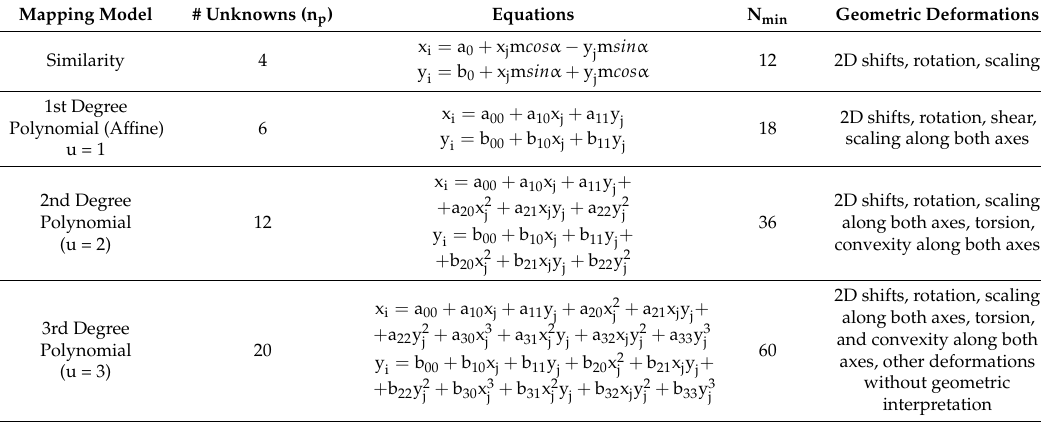
Table 1. Geometric registration models encompassed as subcases of the general planar transformation implemented in MIRA during multi-image